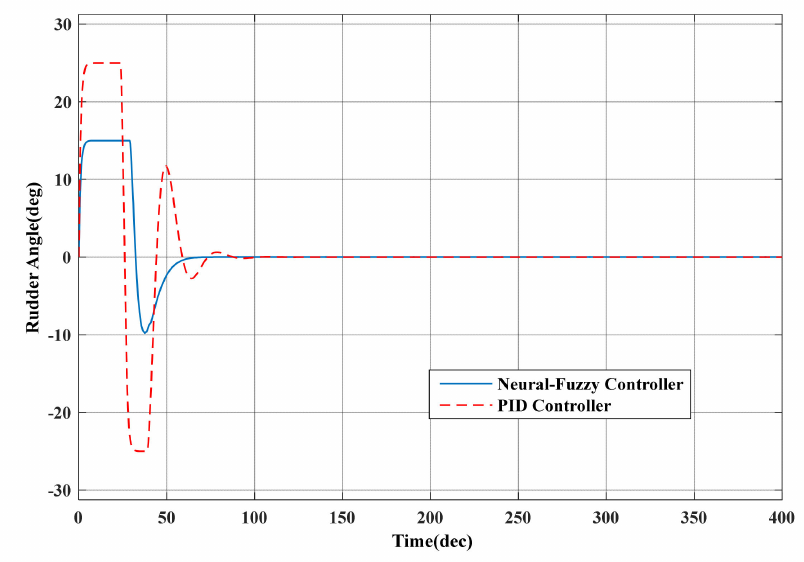
Figure 7. Rudder order outputs of the neuro-fuzzy and PID